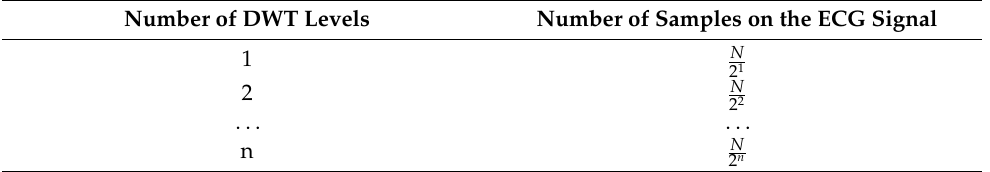
Table 1. Length of ECG signals in DWT, where N is the initial number of samples on the ECG signal. Number of DWT